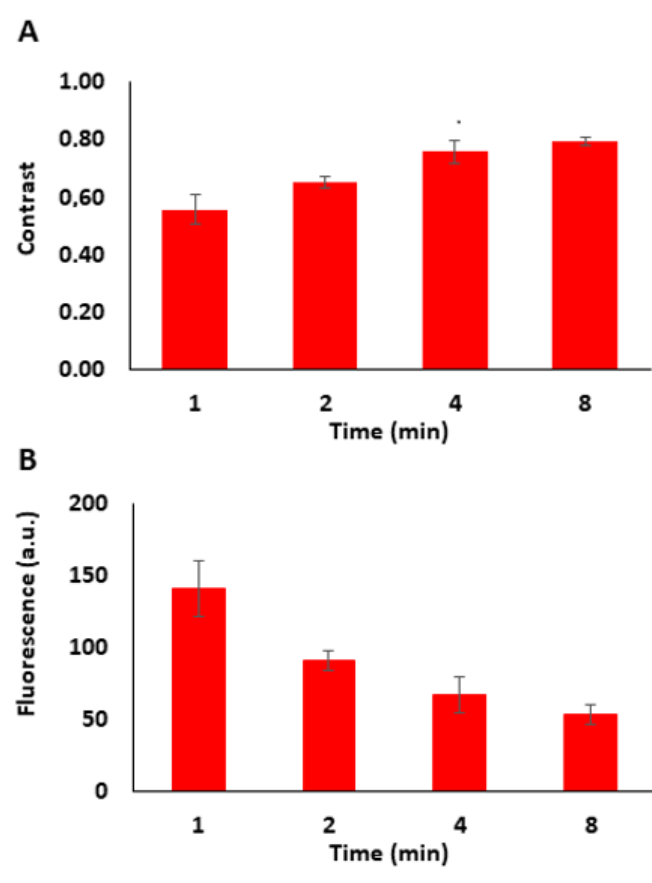
Figure A2. Determination of pattern contrast ( A ) and fluorescence intensity ( B ) of micropatterned fluorescently labeled streptavidin on COP foils via fluorescence microscopy depending on plasma treatment time.